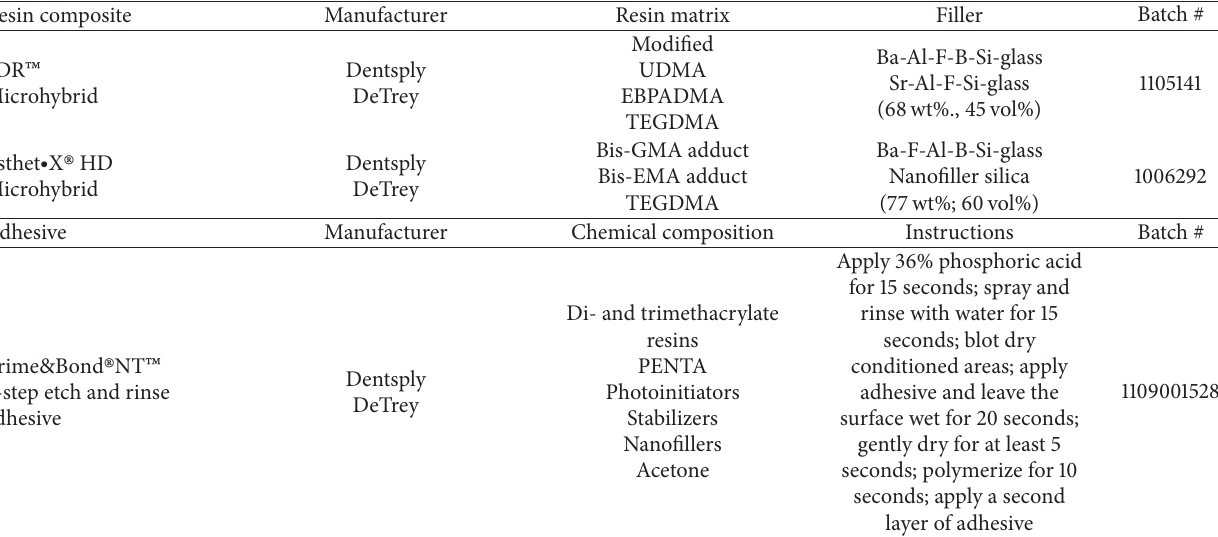
Table 1: Materials composition.